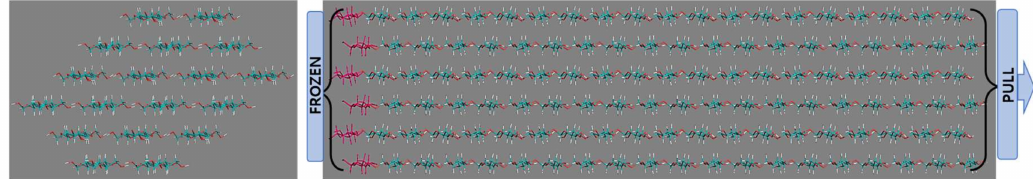
Figure 1. Case A: Representation of cellulose nanofiber (CNF) structure orientation with clear indication of frozen atom groups and pulled group of CNF simulation structure as indicated by the naming arrows in the diagram.